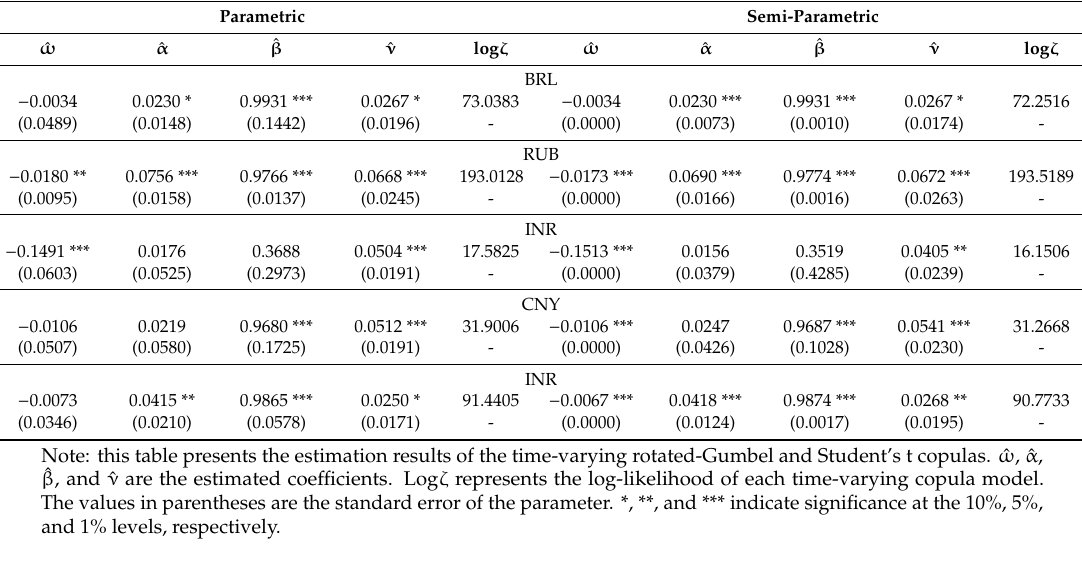
Table 13. Time-varying copula parameter estimation.